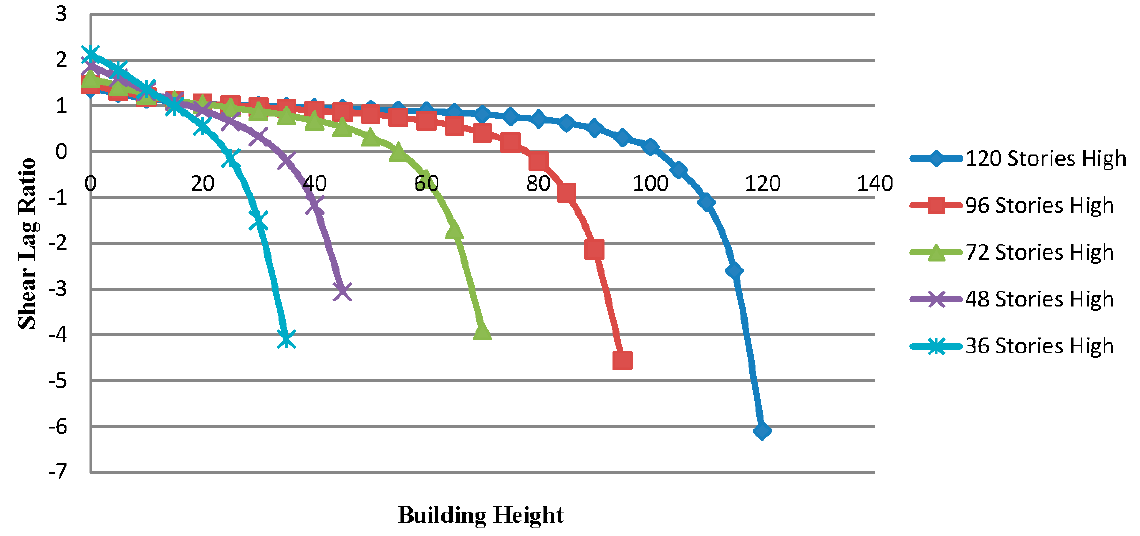
Figure 9. Variation of shear lag ratio vs. the number of